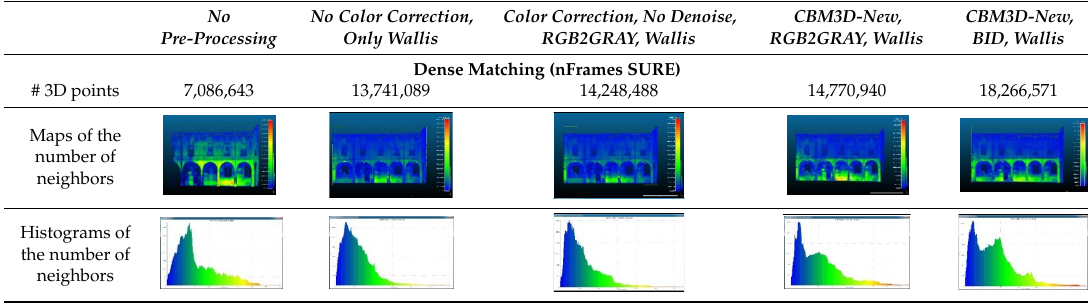
radius R, fixed at 20 cm). The results of the Local Density Computation (shown as color-coded maps and histograms) show that the successive combination of the proposed pre-processing methods gradually achieve, beside an increasing amount of 3D points, a higher density and a more uniform distribution of points. Table 8. Results of dense matching on Dataset 3 without and with various pre-processing methods. The Local Density Computation (radius: 20 cm) is also reported. The color-code maps show the Table 8. Results of dense matching on Dataset 3 without and with various pre-processing methods. Table 8. Results of dense matching on Dataset 3 without and with various pre-processing methods. Table 8. Results of dense matching on Dataset 3 without and with various pre-processing methods. Table 8. Results of dense matching on Dataset 3 without and with various pre-processing methods. Table 8. Results of dense matching on Dataset 3 without and with various pre-processing methods. Table 8. Results of dense matching on Dataset 3 without and with various pre-processing methods. Table 8. Results of dense matching on Dataset 3 without and with various pre-processing methods. Table 8. Results of dense matching on Dataset 3 without and with various pre-processing methods. Table 8. Results of dense matching on Dataset 3 without and with various pre-processing methods. Table 8. Results of dense matching on Dataset 3 without and with various pre-processing methods. matched point distribution on the surveyed scene. The histogram reports the number of neighbors The Local Density Computation (radius: 20 cm) is also reported. The color-code maps show the The Local Density Computation (radius: 20 cm) is also reported. The color-code maps show the The Local Density Computation (radius: 20 cm) is also reported. The color-code maps show the The Local Density Computation (radius: 20 cm) is also reported. The color-code maps show the The Local Density Computation (radius: 20 cm) is also reported. The color-code maps show the The Local Density Computation (radius: 20 cm) is also reported. The color-code maps show the The Local Density Computation (radius: 20 cm) is also reported. The color-code maps show the The Local Density Computation (radius: 20 cm) is also reported. The color-code maps show the The Local Density Computation (radius: 20 cm) is also reported. The color-code maps show the The Local Density Computation (radius: 20 cm) is also reported. The color-code maps show the matched point distribution on the surveyed scene. The histogram reports the number of neighbors matched point distribution on the surveyed scene. The histogram reports the number of neighbors matched point distribution on the surveyed scene. The histogram reports the number of neighbors matched point distribution on the surveyed scene. The histogram reports the number of neighbors matched point distribution on the surveyed scene. The histogram reports the number of neighbors (X-axis) versus the number of matched points in the cloud (Y-axis). matched point distribution on the surveyed scene. The histogram reports the number of neighbors matched point distribution on the surveyed scene. The histogram reports the number of neighbors matched point distribution on the surveyed scene. The histogram reports the number of neighbors matched point distribution on the surveyed scene. The histogram reports the number of neighbors matched point distribution on the surveyed scene. The histogram reports the number of neighbors (X-axis) versus the number of matched points in the cloud (Y-axis). (X-axis) versus the number of matched points in the cloud (Y-axis). (X-axis) versus the number of matched points in the cloud (Y-axis). (X-axis) versus the number of matched points in the cloud (Y-axis). (X-axis) versus the number of matched points in the cloud (Y-axis). (X-axis) versus the number of matched points in the cloud (Y-axis). (X-axis) versus the number of matched points in the cloud (Y-axis). (X-axis) versus the number of matched points in the cloud (Y-axis). (X-axis) versus the number of matched points in the cloud (Y-axis). (X-axis) versus the number of matched points in the cloud